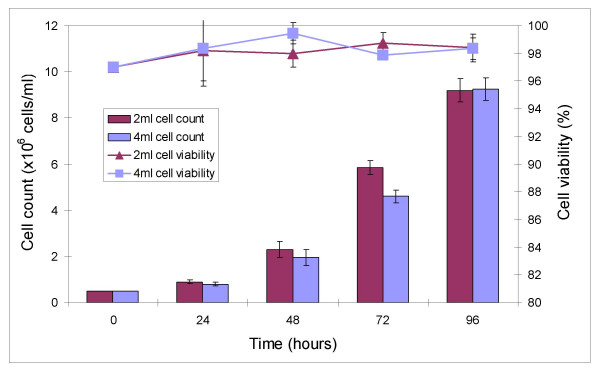
Comparison of HEK-293E cell growth in different volumes within a 24 well block. Cells were seeded at 0.5 × 106 cells/ml in either 2 ml or 4 ml. Cells were analysed in duplicate and counted using a Neubauer haemocytometer to calculate cell growth and viability.